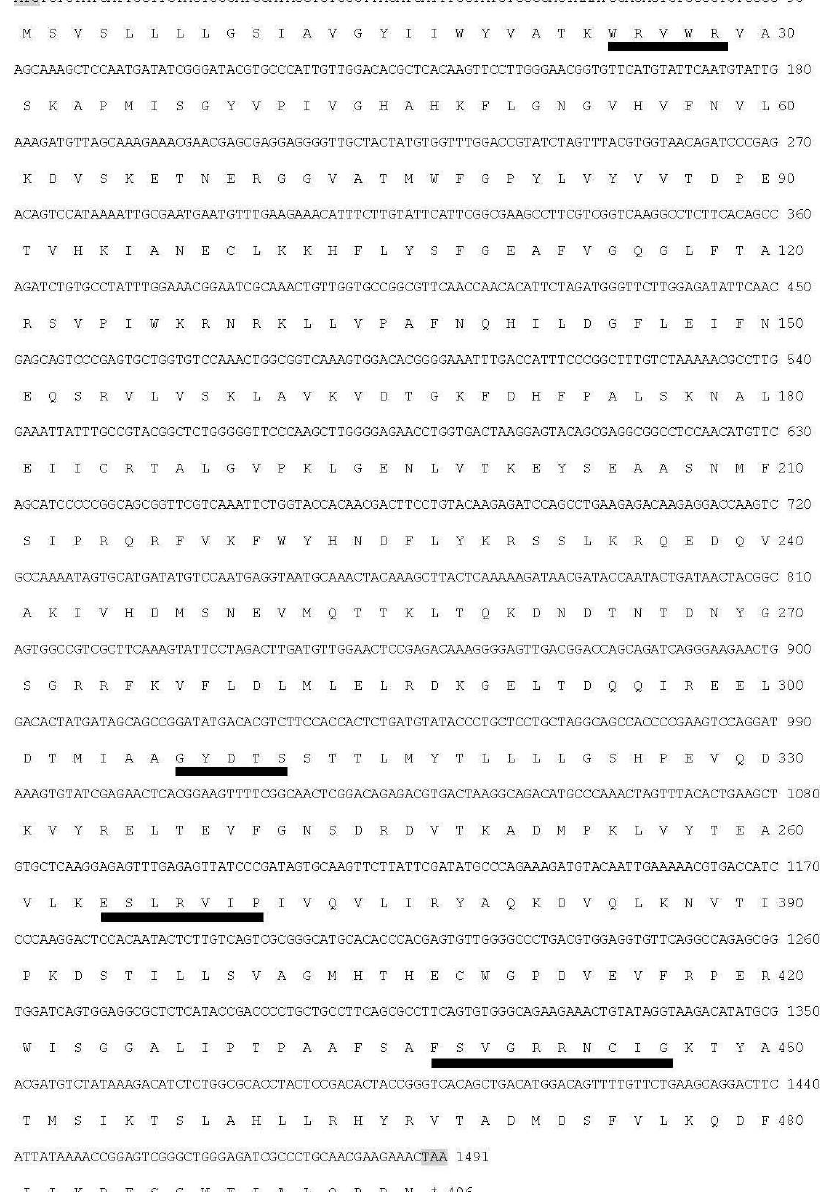
Figure 1. Nucleotide sequence and deduced amino acid sequence of CYP340W1 in P. xylostella . The following P450 signature motifs are underlined in black: helix C motif (position 24), the oxygen-binding motif (helix I) (position 307), the helix K motif (position 363), and the heme-binding motif (position 437). The initiation and termination codons are shaded gray color. * indicates stop codon. 2.2. Expression Profile of CYP340W1 in Different Developmental Stages and Tissues of P.